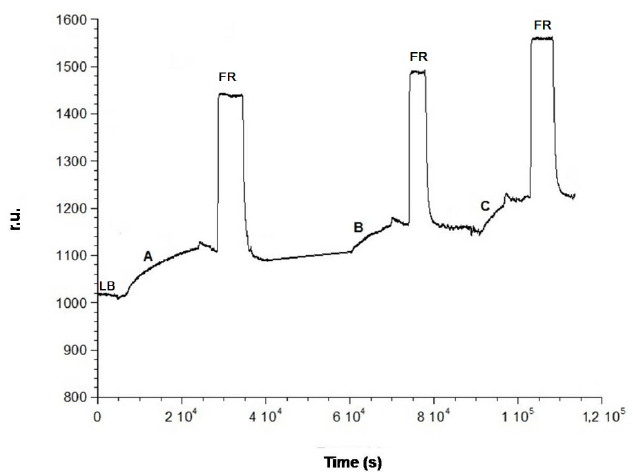
Figure 6. Antibody complexation on the SAM coated with the antygen: ( A ) 6 × 10 − 10 M; ( B ) 8 × 10 − 10 M; Figure 6. ( C ) 1 × 10 − 9 M, anti-ampicillin flowing successive solutions; ( FR ) regeneration step by flowing Gly-HCl at pH 2.4.